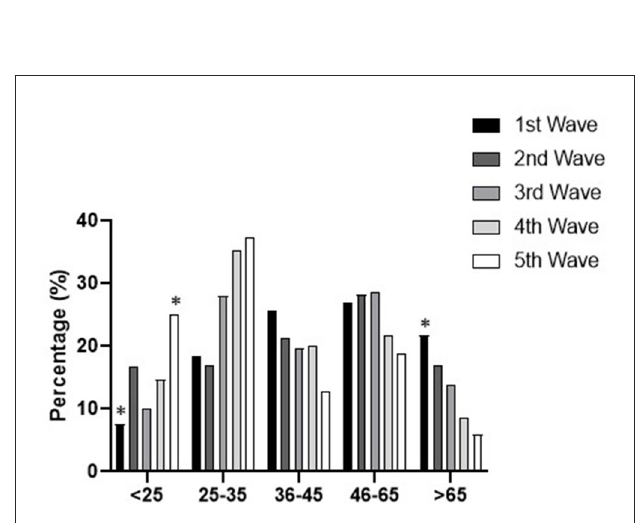
FIGURE5 Patient age distribution profile according across waves. Statistical differences: * p < 0.05 vs. the value in the total pandemic.